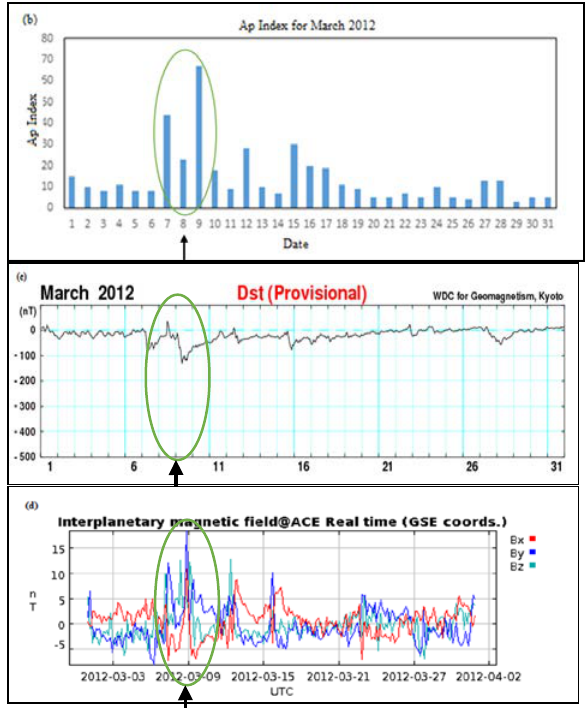
Figure 3. Geomagnetic index for March 2012. (a) Kp index. ©